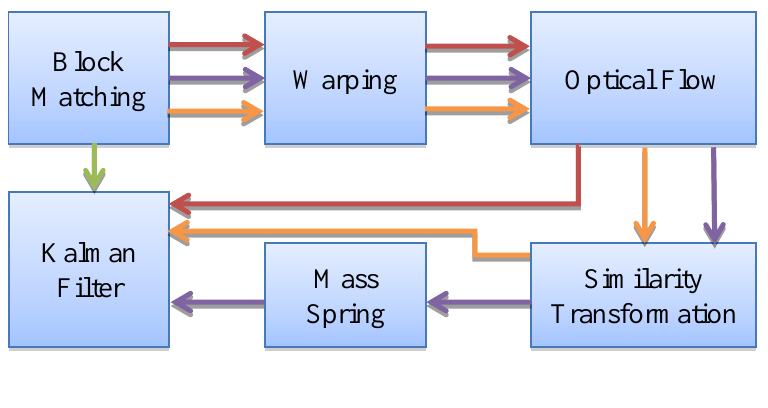
Figure 5. Incorporation of Kalman Filter in the previously proposed schemes. Each scheme is encoded with a different